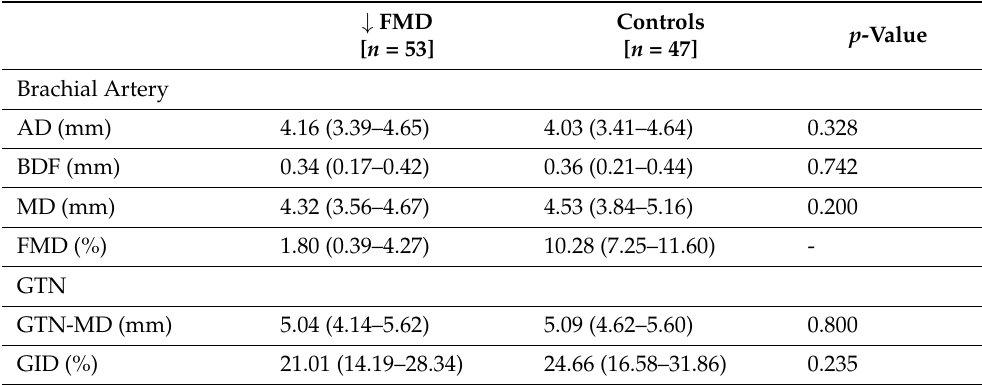
Table 1. Brachial Artery Reactivity Assessments.